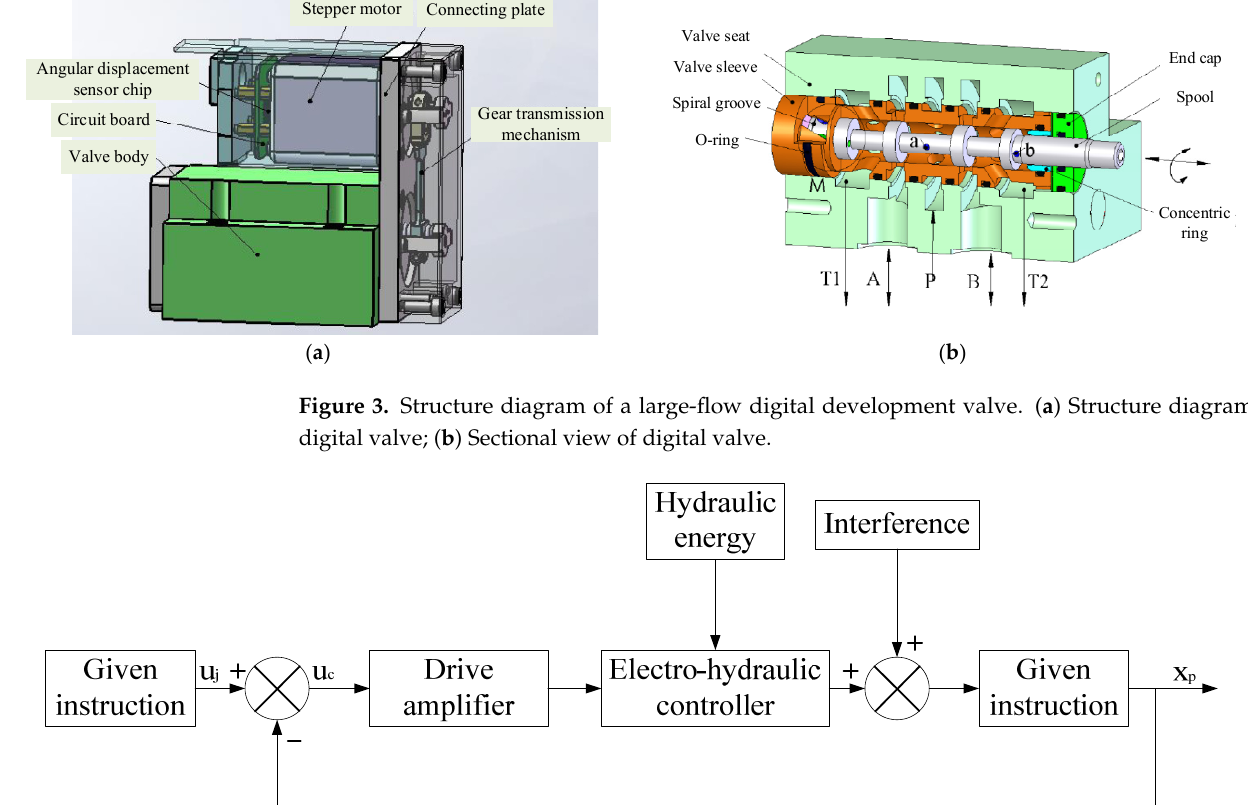
Figure 4. Schematic diagram of a hydraulic cylinder controlled by a traditional servo valve.